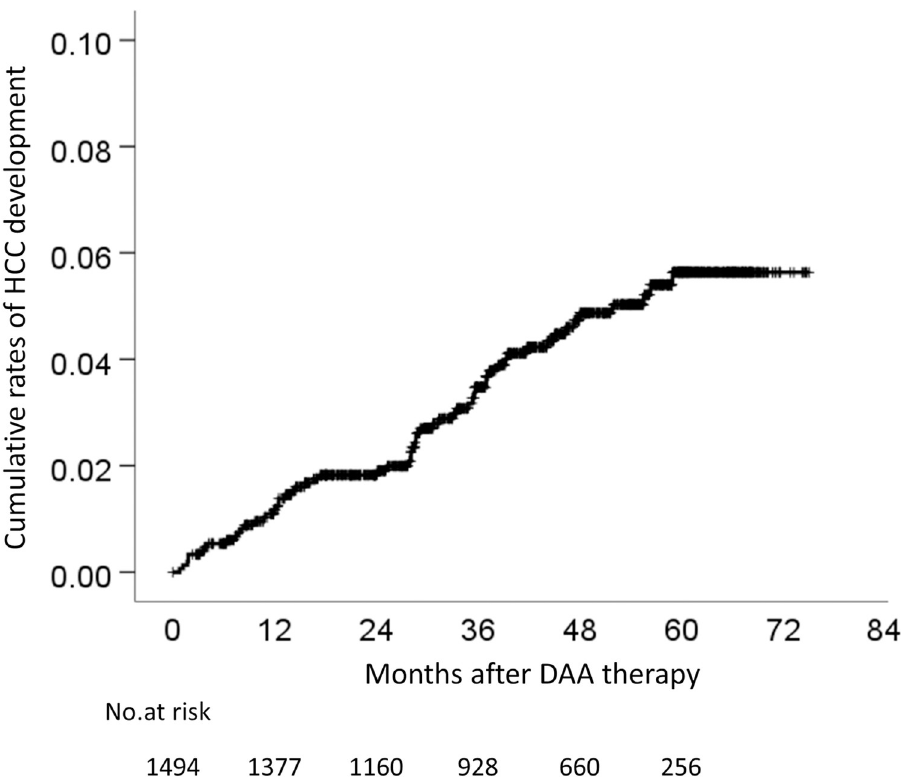
Fig 2. Cumulative rates of HCC development in patients with DAA-SVR. HCC, hepatocellular carcinoma; DAA, direct-acting antiviral; SVR, sustained virologic response.